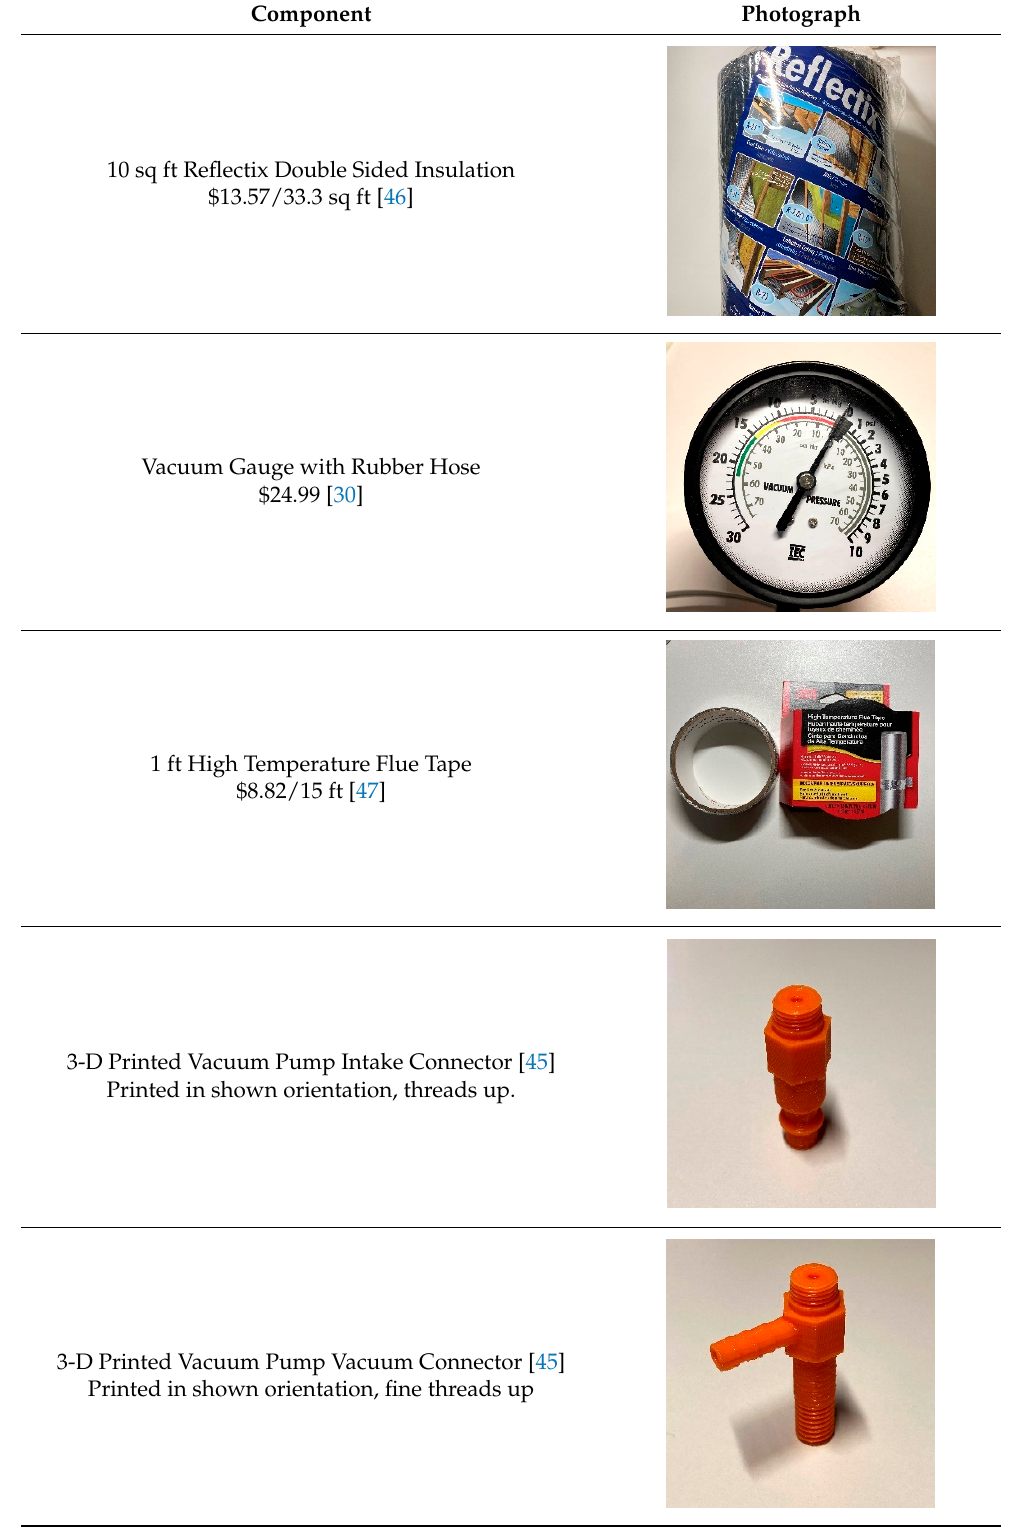
Table A1. Cont. Component